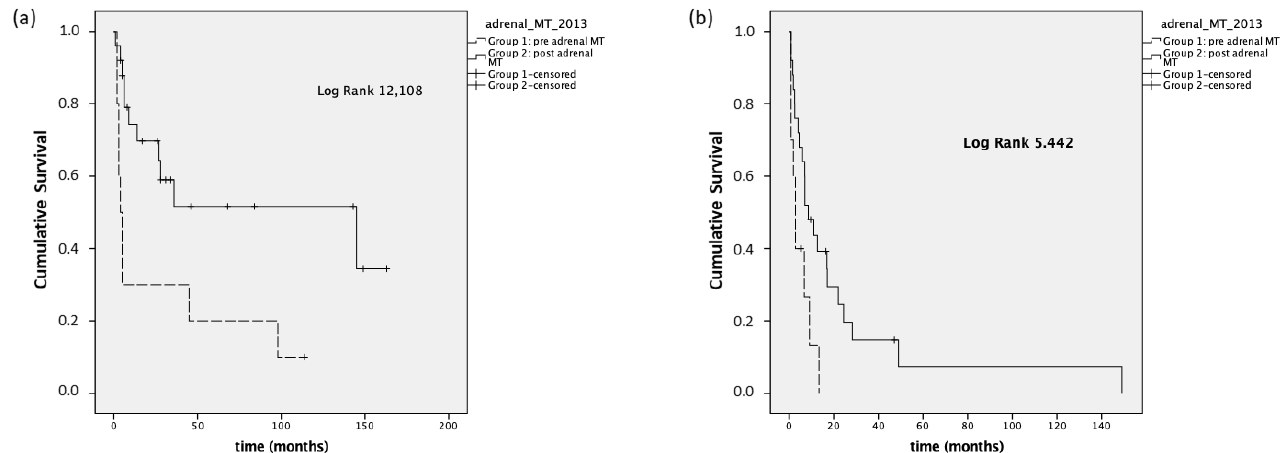
Figure 3. Panel ( a ): PFS first treatment , stage I–IV; panel ( b ): PFS first treatment , stage III–IV. We also performed a PFS analysis considering the time from the first visit to our center to the appearance of progression disease (PFS first visit ). Group 1 presented a median PFS first visit of 4 months (95% CI 0–8.4), while the median PFS first visit was equal to 14.7 months (95% CI 7.9–21.5) in Group 2 ( p = 0.128). In stage III-IV patients, the median PFS first visit was 4.1 months (95% CI 0.3–7.7) and 9.6 months (95% CI 2.3–16.8), respectively, in Group 1 and Group 2 ( p = 0.915, Figure 4).